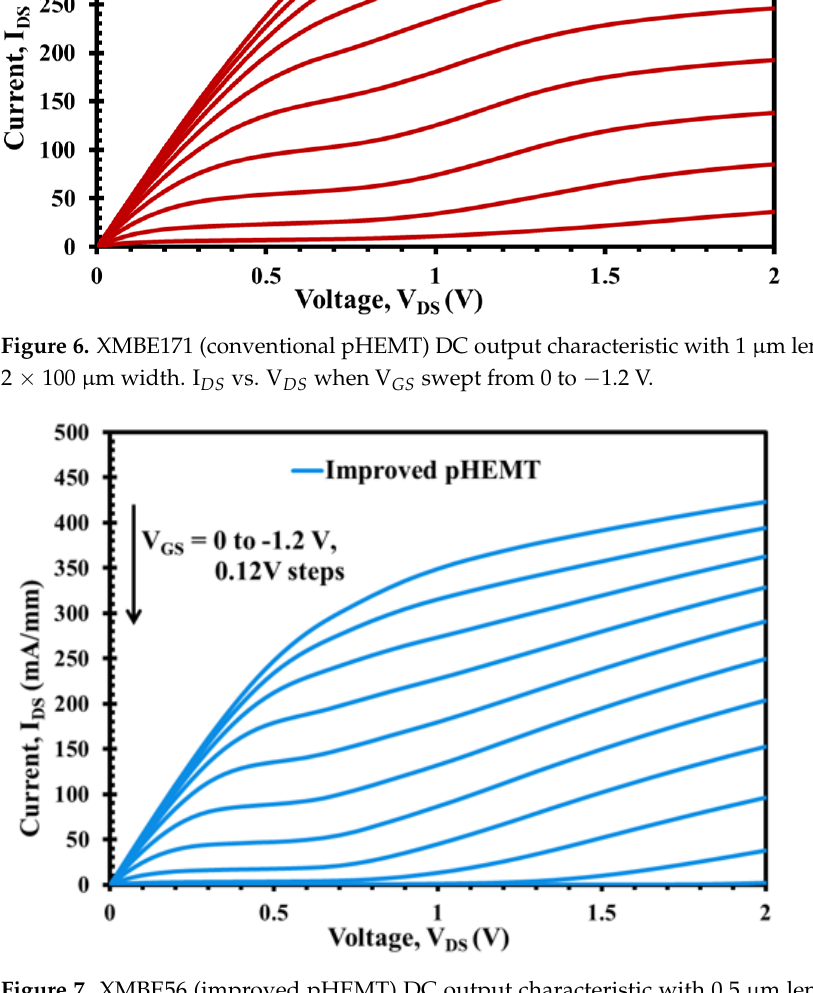
Figure 7. XMBE56 (improved pHEMT) DC output characteristic with 0.5 µ m length multigate of 2 × 100 µ m width. I DS vs. V DS when V GS swept from 0 to − 1.2